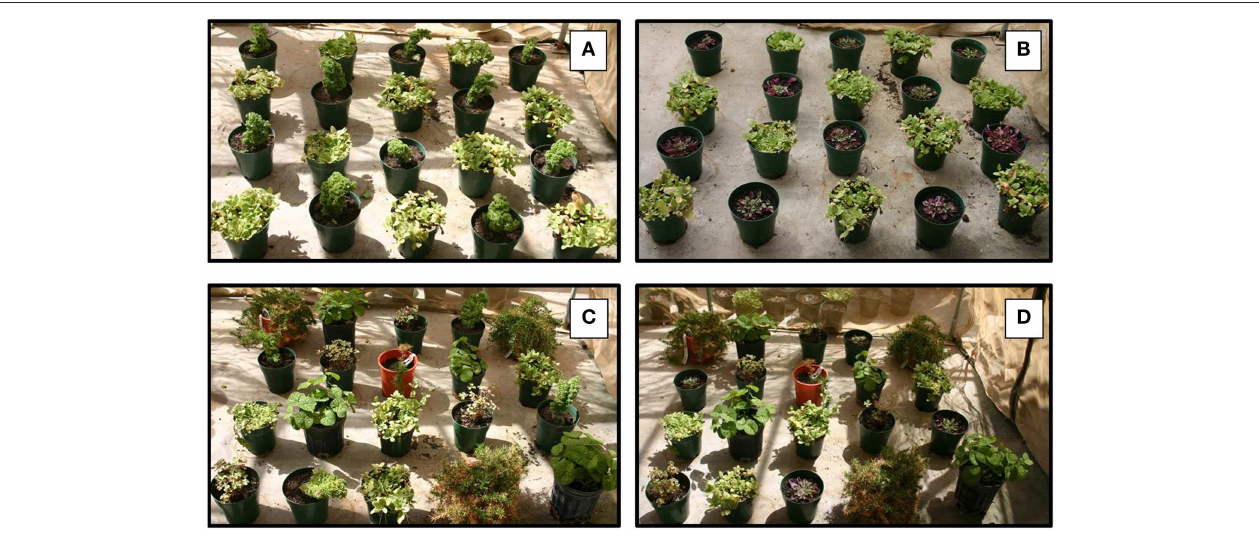
FIGURE 2 | Experimental setup. Individual female butterflies experienced environments that varied in host color (green vs. red color) or non-host complexity, which varied in diversity and density of non-hosts. (A) Green